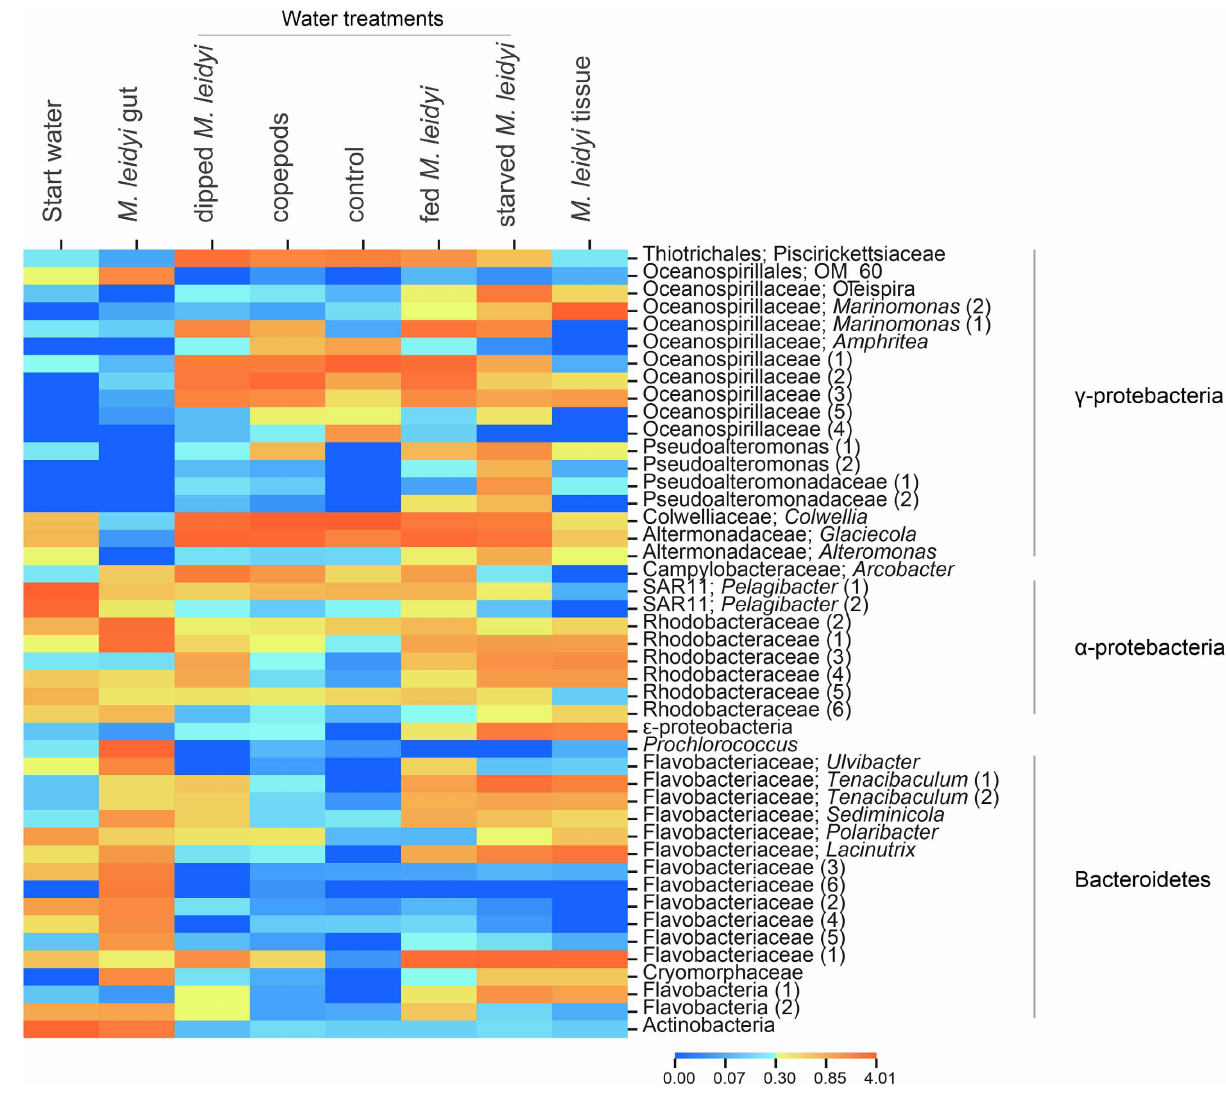
FIGURE 4 | Heatmap displaying the relative abundances of specific OTUs across the samples. Only OTUs with a sum of > 100 assigned sequences across all samples were used. The color scale represents the log10 + 1 transformed relative abundance of the number of sequences. Duplicate OTUs were numbered sequentially for